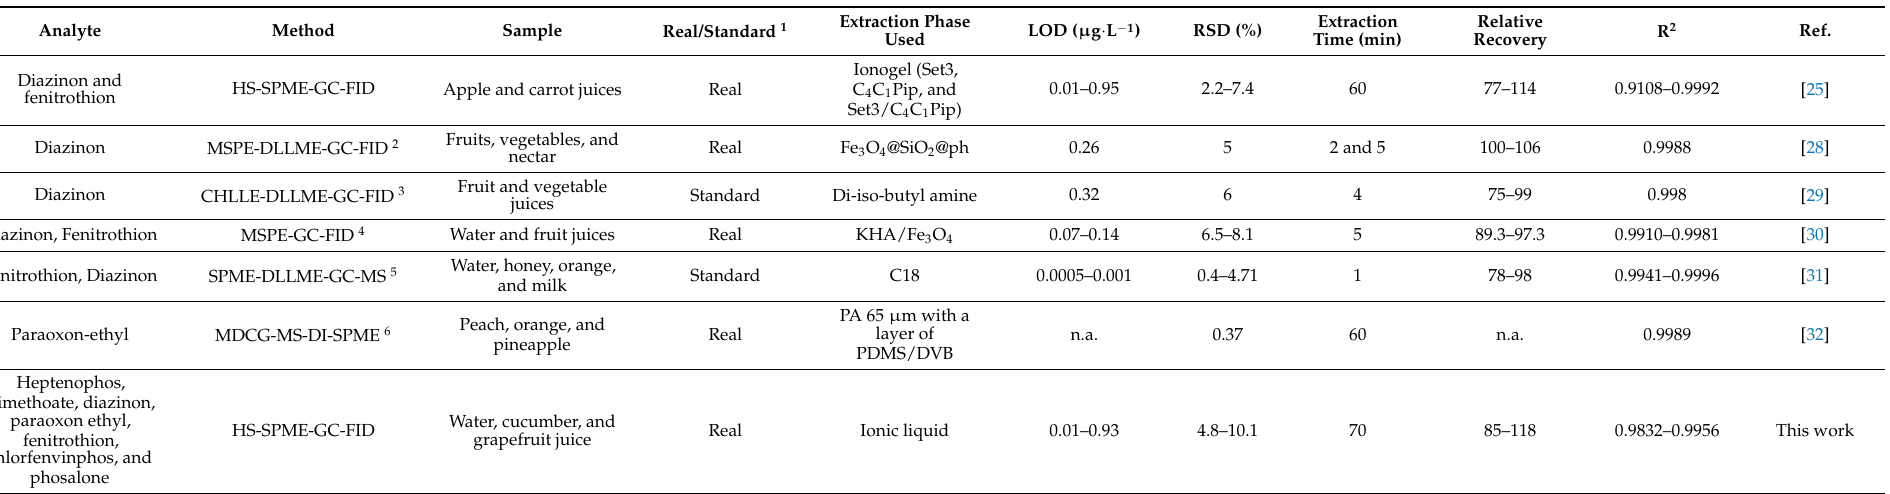
Table 3. Comparison of the proposed HS-SPME-GC-FID method with other methods available in the literature dedicated to the determination of the insecticides investigated in this